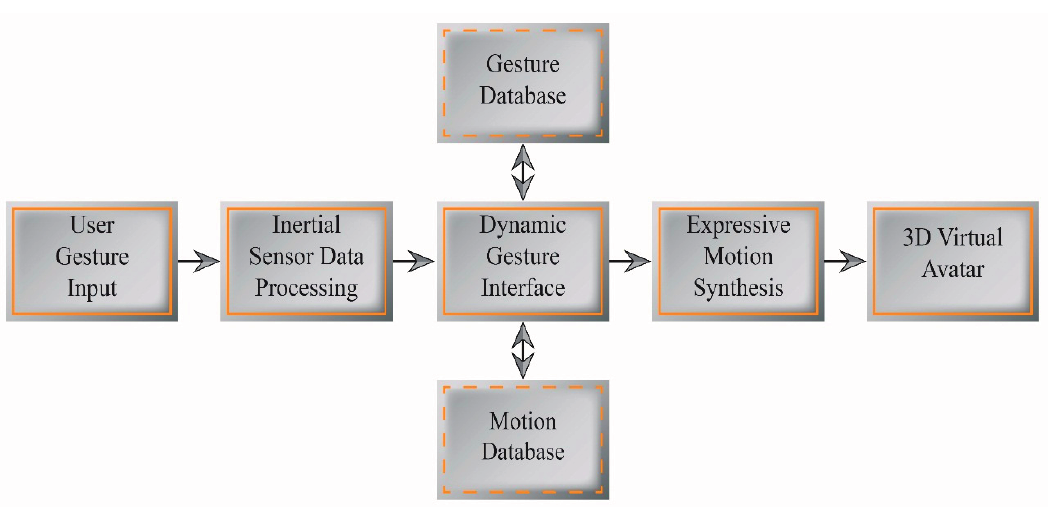
Figure 1. Dynamic gesture-based expressive control interface